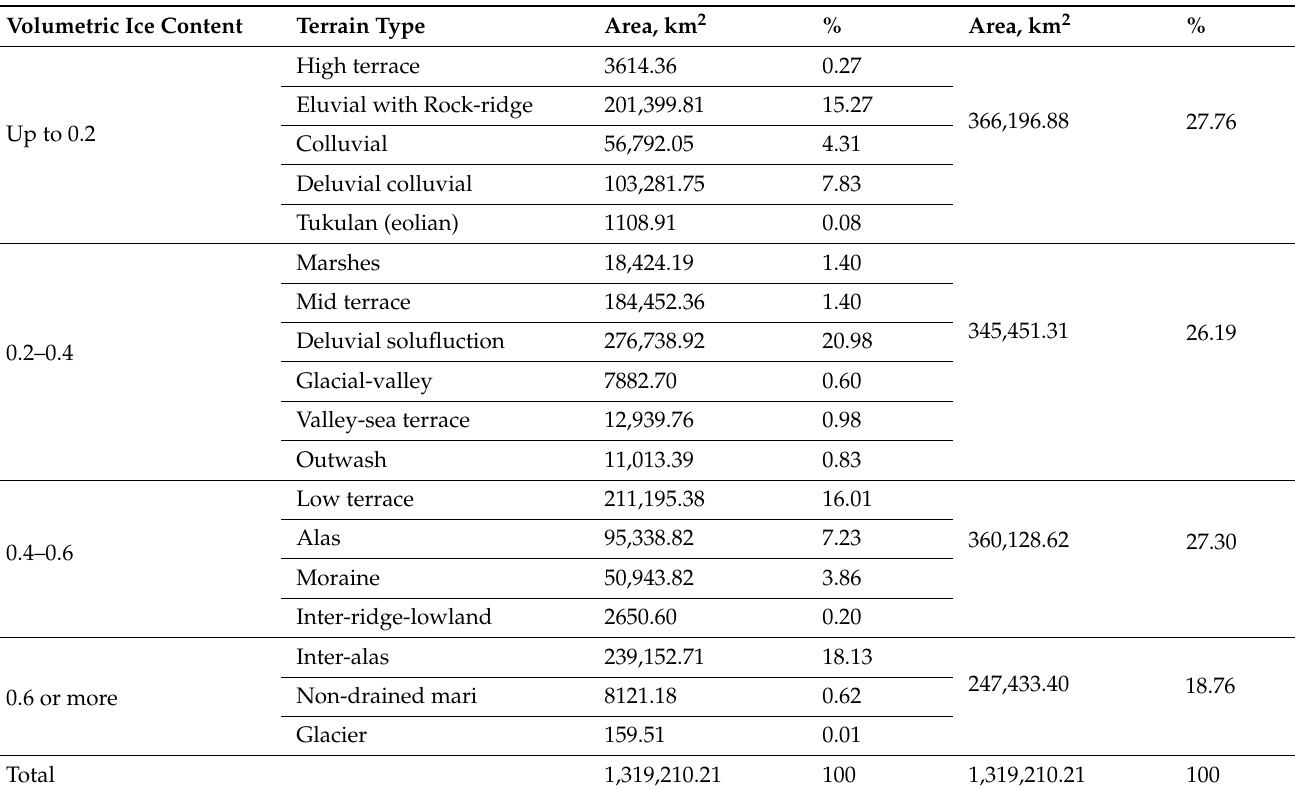
Table 2. Volumetric ice content in terrain types, Arctic